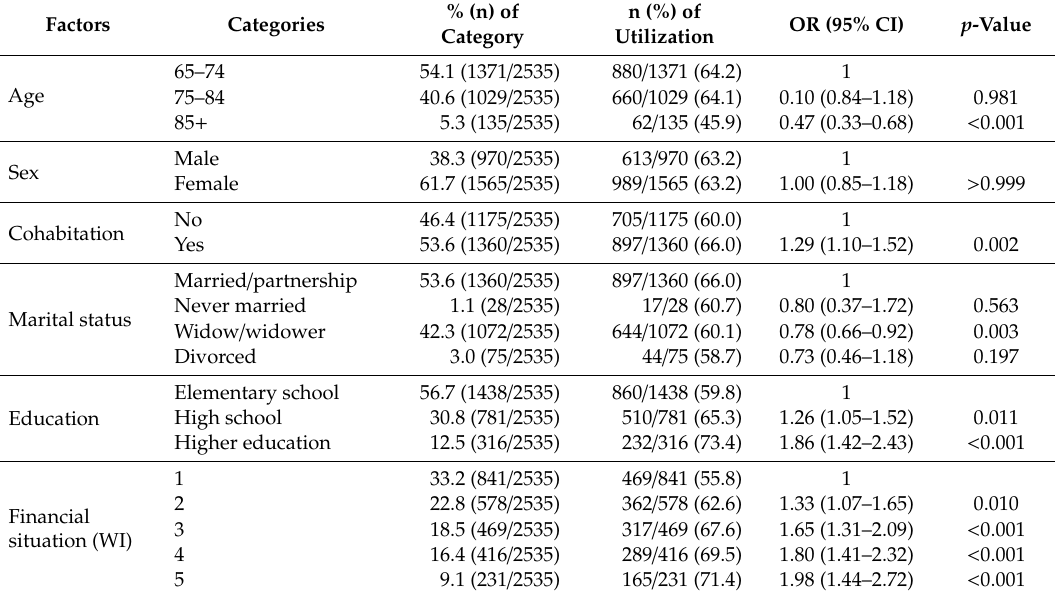
Table 2. Univariable analysis of the utilization of specialist healthcare services by elderly CVD patients in the Republic of